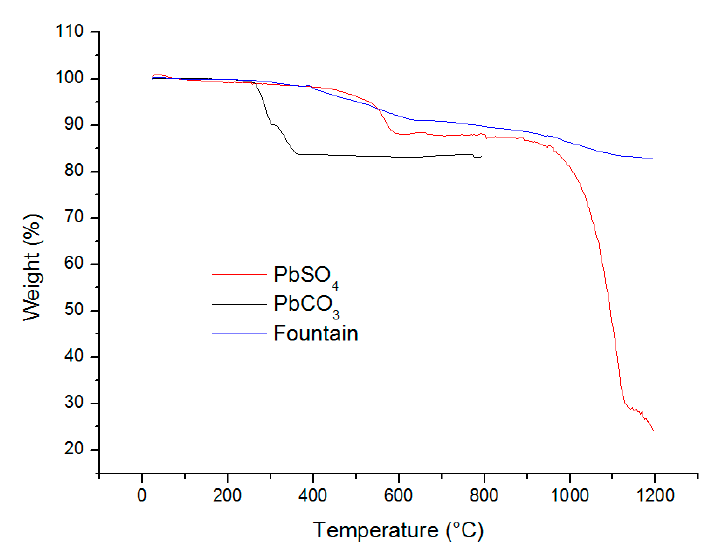
Figure 14. Thermal degradation curve showing the losses in each step with a rate of 10 °C/min.